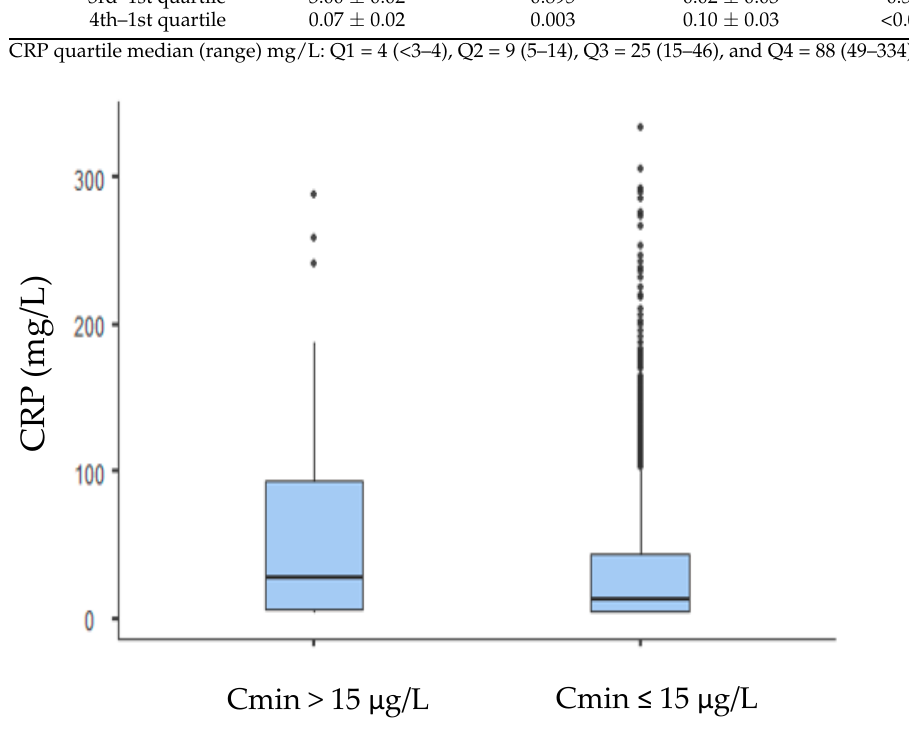
Figure 2. Relationships between tacrolimus blood exposure (normal range (<15 µg/L, n = 1482) or overexposure (>15 µg/L, n = 91) and CRP concentration. Data are presented as interquartile range (boxes), data range (whiskers), and median (hor- izontal line). Table 3. Univariate and multivariate linear mixed-effect regression analyses for the identification of the determinants of tacrolimus overexposure (tacrolimus trough concentrations > 15 µg/L ( n = 91)) during longitudinal therapeutic drug monitoring.